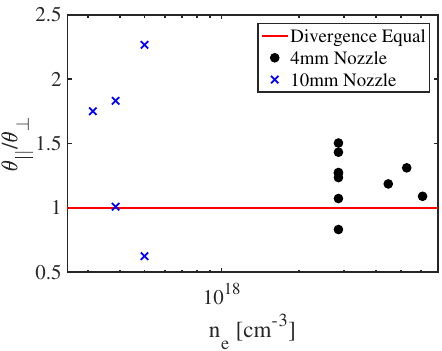
FIG. 2. The ratio of the measured electron beam divergence parallel ( θ k ) and perpendicular ( θ ⊥ ) to the linear laser polariza- tion. Ratios greater than 1 indicate an elongation along the laser polarization.